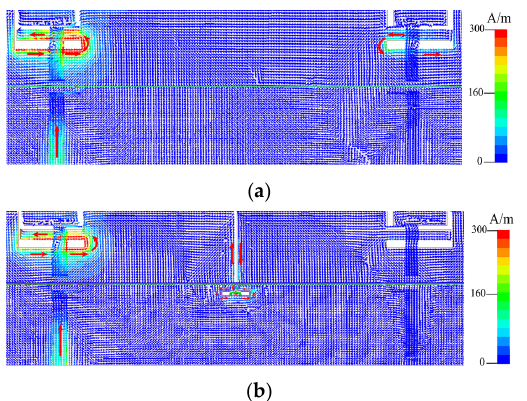
Figure 9. Surface vector current distributions. ( a ): Without decoupling structure and ( b ): with decoupling structure of Ant 1 and 2.